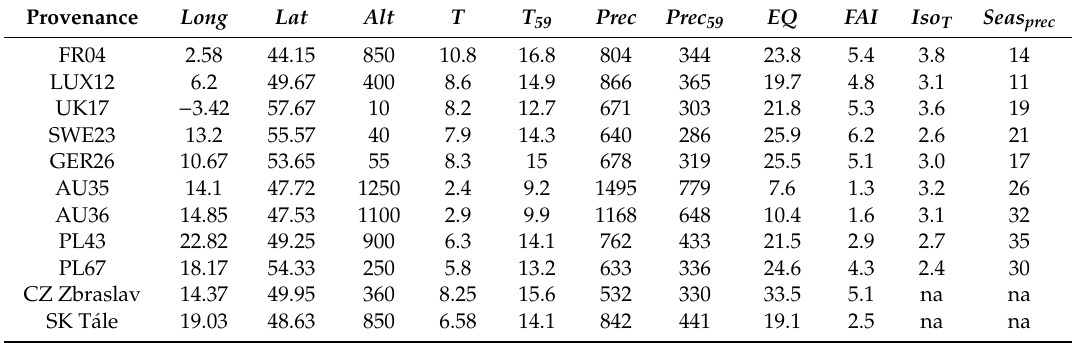
Table 1. Geographic and climate characteristics of provenance plots and their original locations.